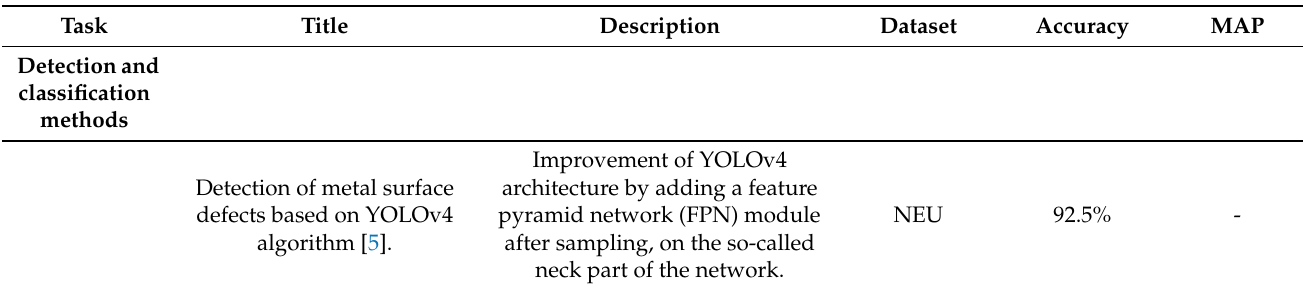
Table A1. Steel surface detection methods discussed in Section